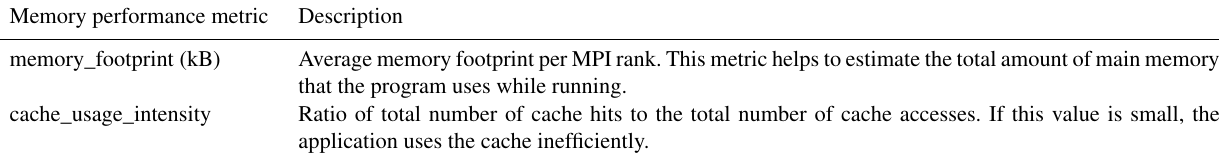
Table B4. Description of performance analysis metrics pertaining to memory use, currently supported by our RCF. Memory performance metric Description